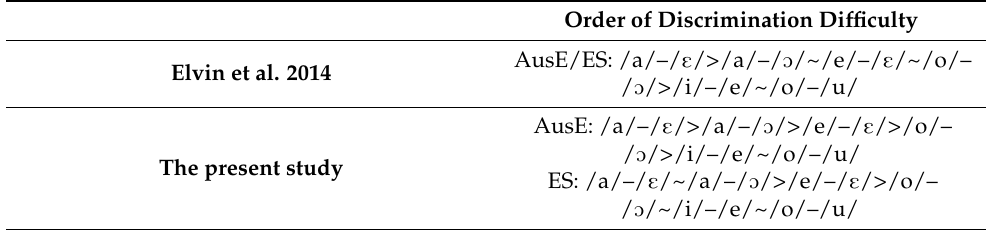
Table 9. Reported patterns of discrimination accuracy in Elvin et al. (2014) and the present study beginning from perceptually easy to perceptually